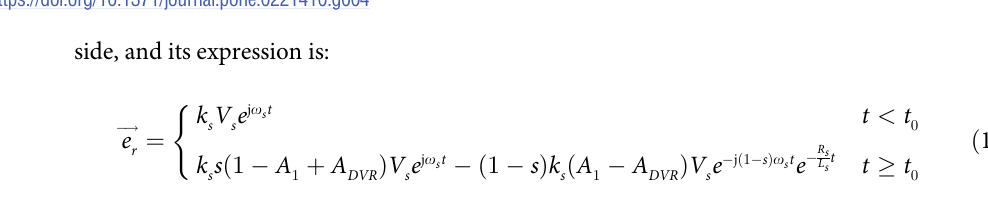
Fig 4. Topological structure of the inductive FCL. (a) Main connection, (b) equivalent circuit.